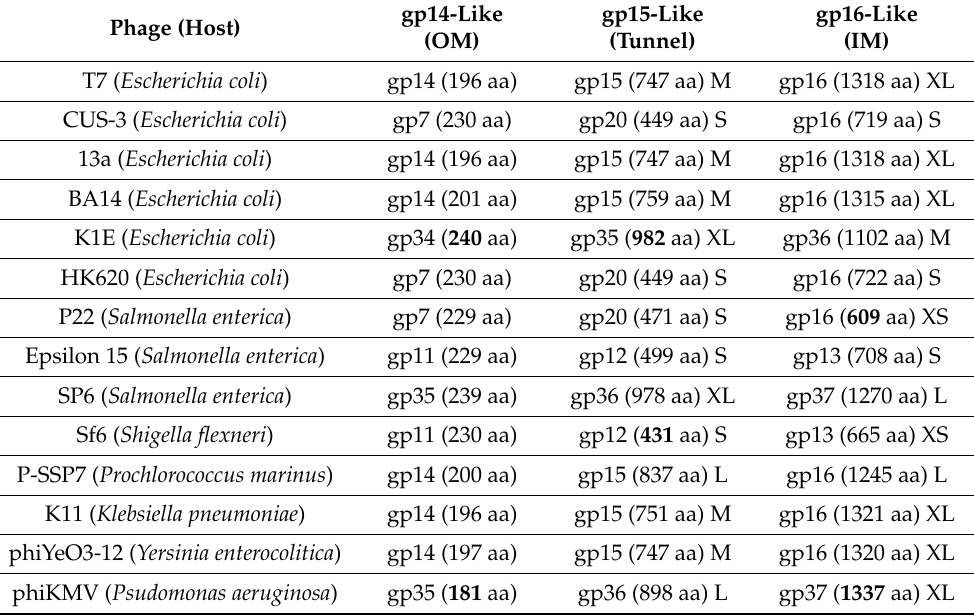
Table 1. List of gene factors homologous to T7 gp14, gp15 and gp16. Highlighted in bold are the largest and smallest representatives of each group. Annotations for gp15-like and gp16-like gene factors ranging from extra-small (XS) to extra-large (XL) included for comparison within each